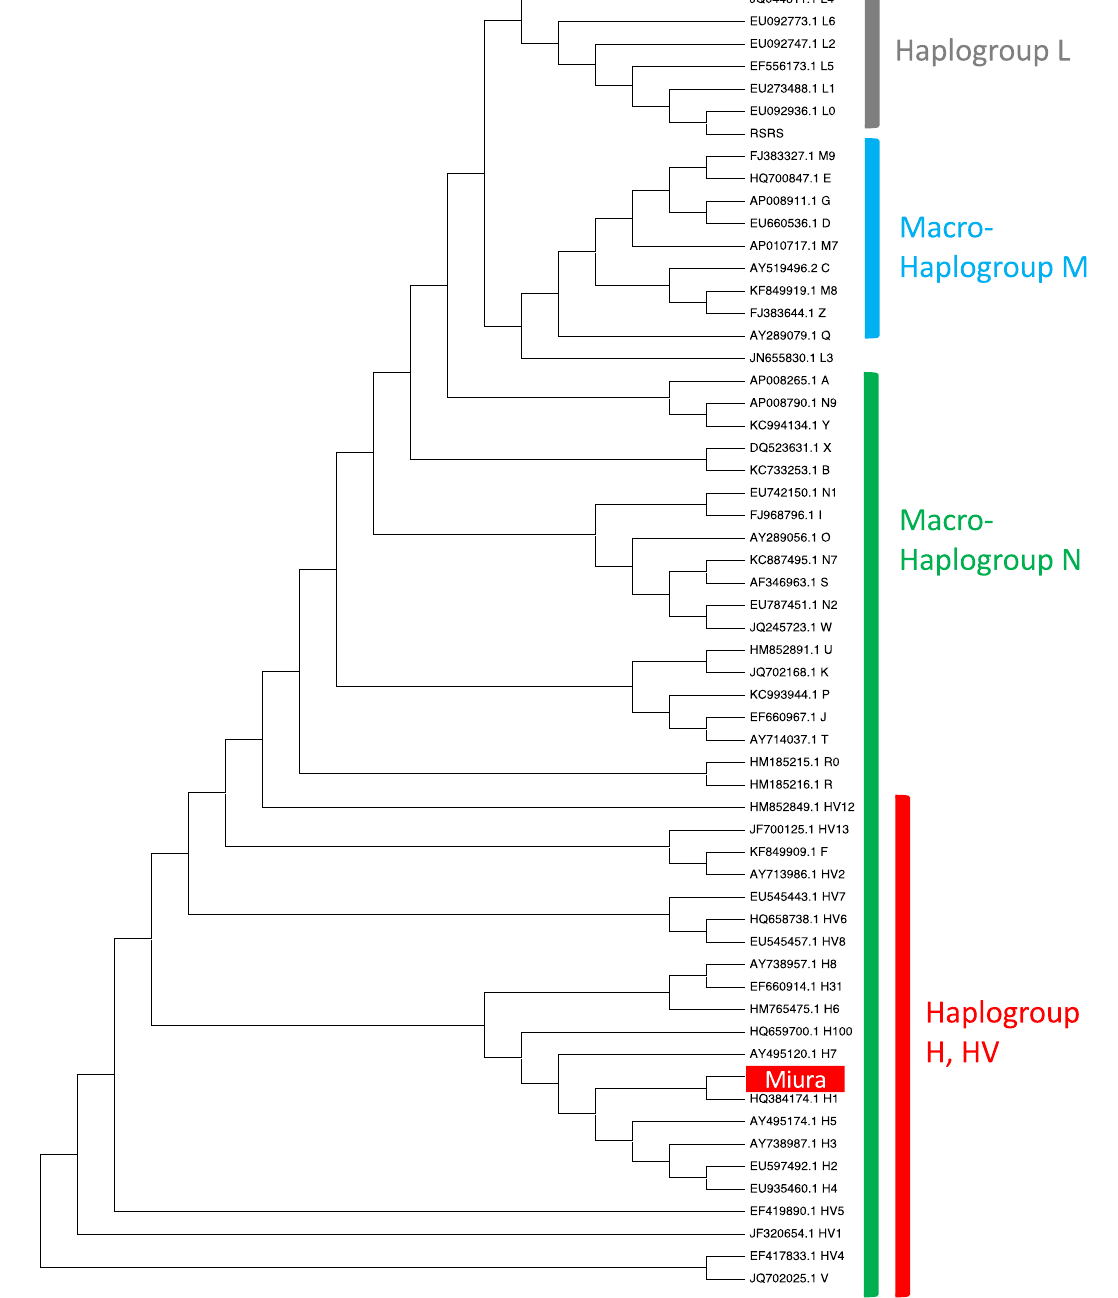
Figure 3. A Maximum-Parsimony tree for mtDNA sequences of Miura Anjin and 57 worldwide mtDNA sequences belonging to haplogroups L, M, A, B, C, D, E, F, G, H, I, J, L, M, N, O, P, Q, R, S, T, V, W, X, Y, and Z. The accession number and haplogroup are described in the phylogenetic